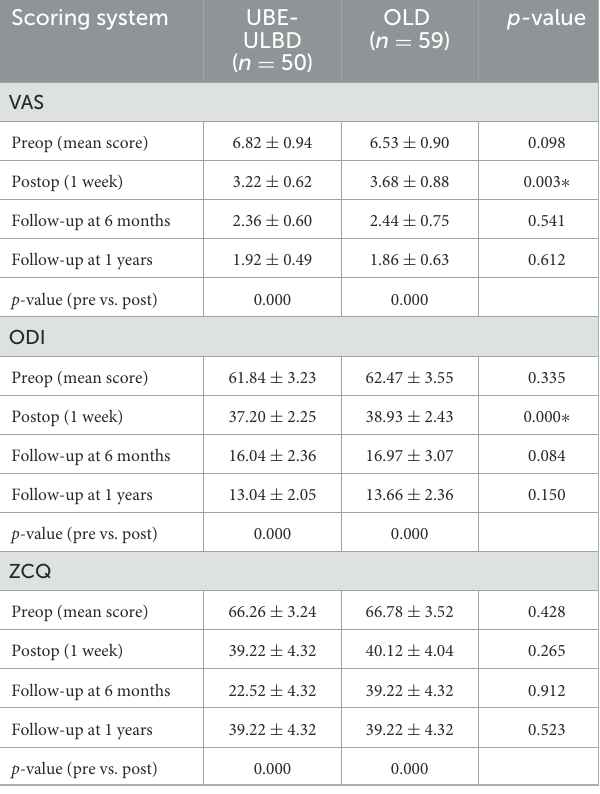
TABLE 4 Comparison of postoperative VAS, ODI, and ZCQ